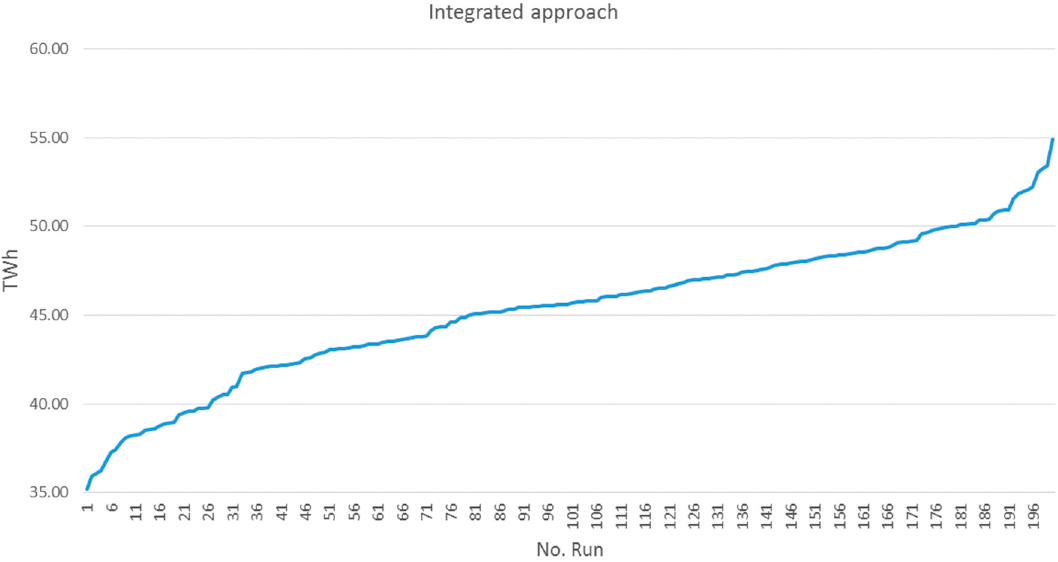
Figure 8. Estimated energy use by using an integrated approach of energy saving upon the Mexican residential sector.